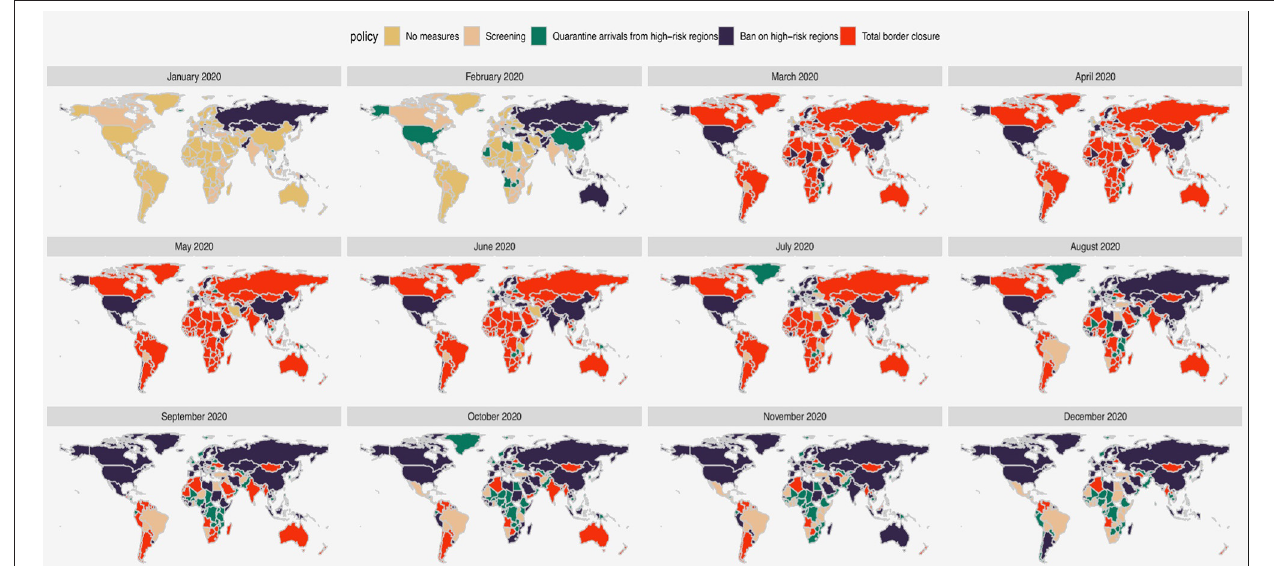
FIGURE 5 | World map of trends in international travel controls policies.